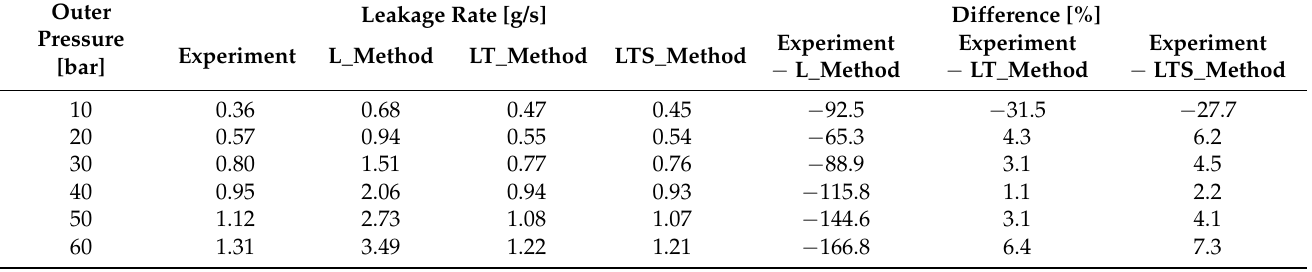
Figure 7. Measured and simulated leakage rate according to the change of the outer pressure.